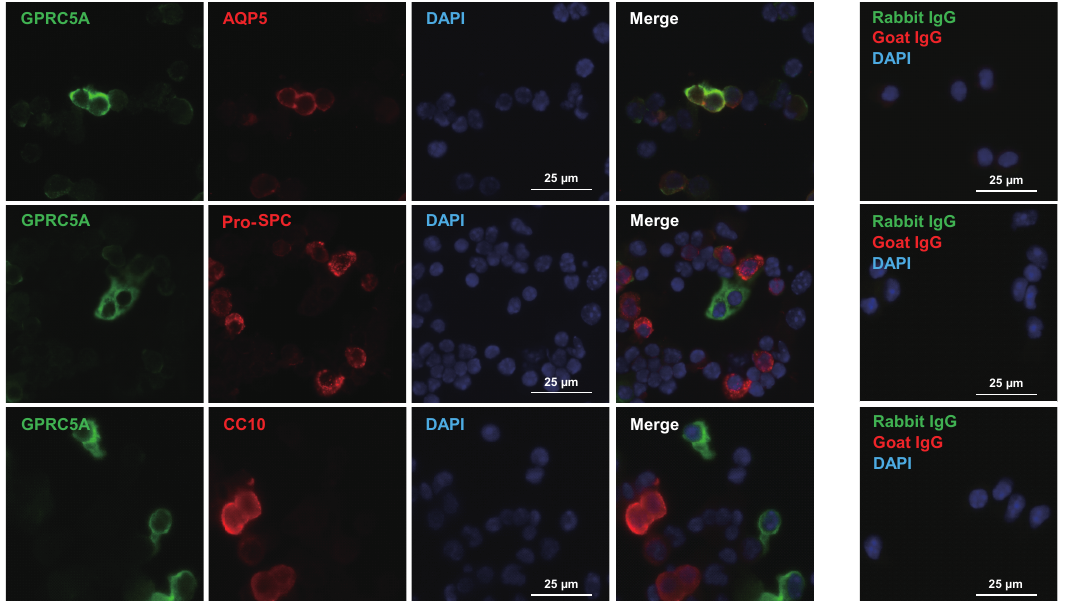
Figure 7. Co-staining of GPRC5A with AQP5, pro-SPC and CC10 in crude cytospin preparations from mouse lung. Representative double staining for GPRC5A (green) and AQP5 (upper panel, red), pro-SPC (middle panel, red) or CC10 (lower panel, red) in cytospins of crude preparations from digested mouse lung tissue. Blue = DAPI. Rabbit and goat IgG were negative